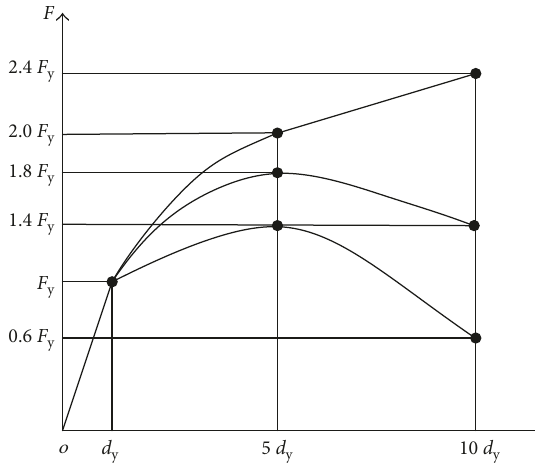
Figure 13: Envelop curve with parabolic postyield branch.